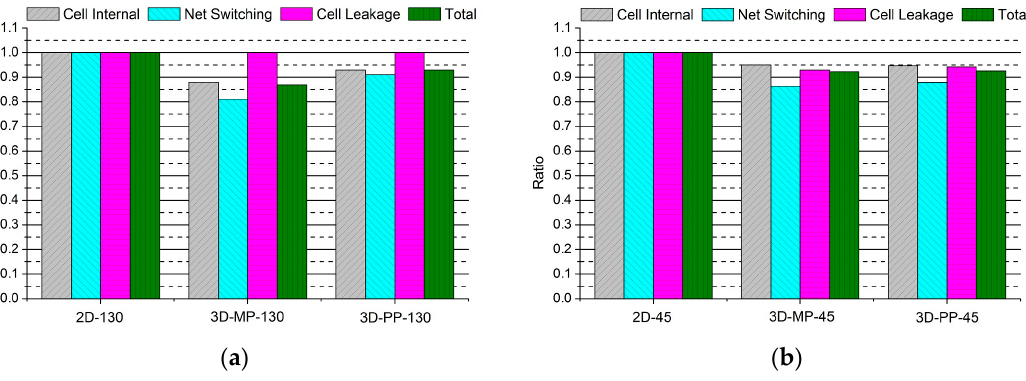
Figure 14. Normalized power comparisons of 2D and 3D ICs: ( a ) 130-nm process technology and ( b ) 45-nm process technology. Table 8. Detailed power comparisons of 2D and 3D ICs designed in 130-nm technology. Design